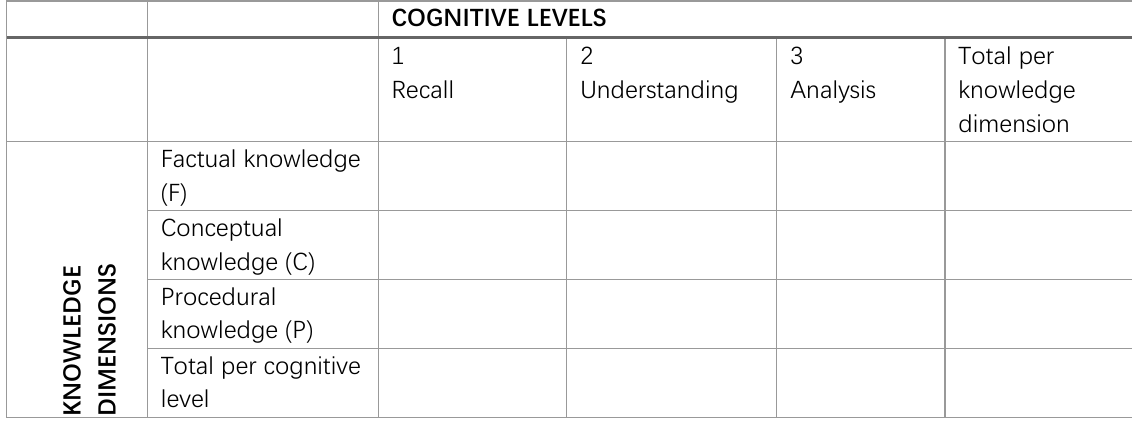
Table 1 : Rubric showing the hierarchy of cognitive levels and knowledge dimensions that were assessed by means of the test